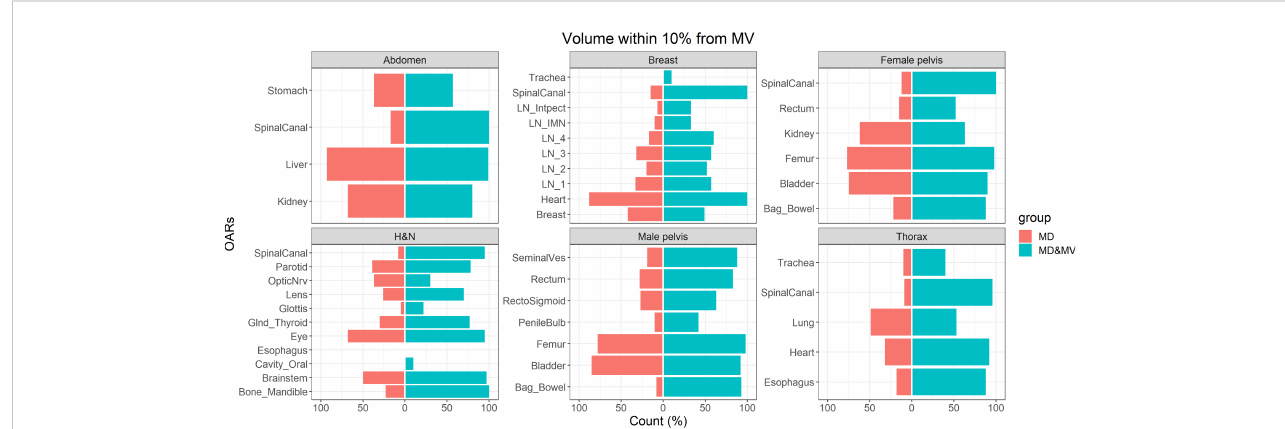
FIGURE 4 The percentage number of OARs with rV within 10% with the VOIs delineated by MV grouped for the tumoral district and type of delineation (i.e., MD or MD & MV). The absence of the colored bar (e.g., for the esophagus in the H&N district) indicates that the comparison did not produce any count as rV between each considered VOI (i.e., for each RO and type of delineation) compared to the MV-based one exceeded the 10%. See the de fi nition of Figure 1